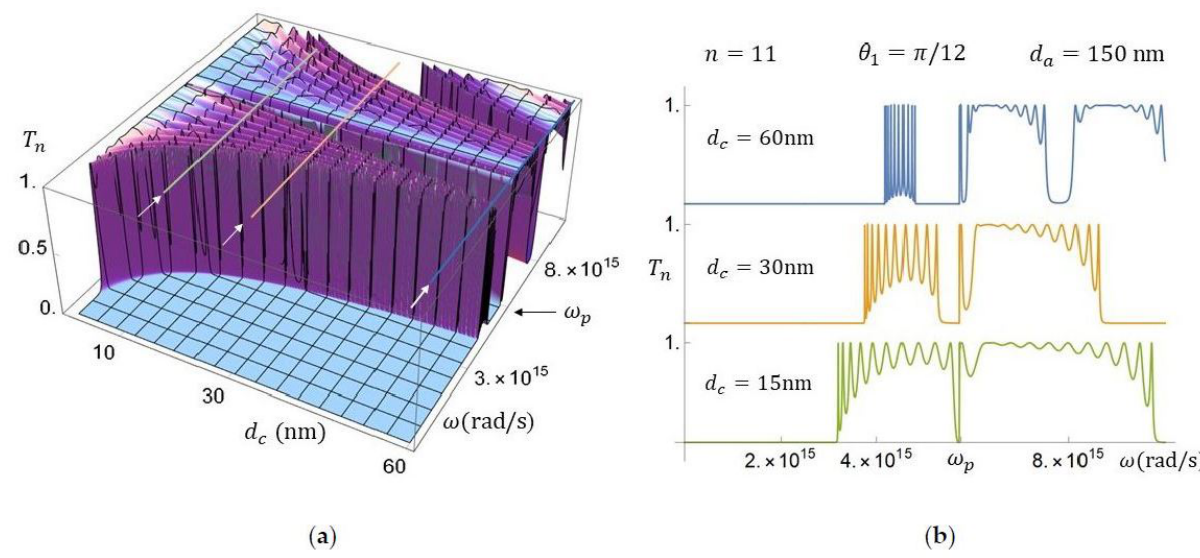
Figure 11. Transmission coefficient as a function of ω and d c , for a metallic superlattice with n = 11, d a = 150 nm and θ i = π /12. In subfigure ( a ), the band width diminishes as the conductor layer width d c increases. This effect is shown in subfigure ( b ) for three values of d c , indicated with white arrow in subfigure ( a